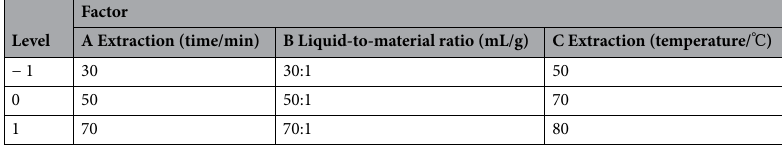
Table 3. Factors adopted in the BBD